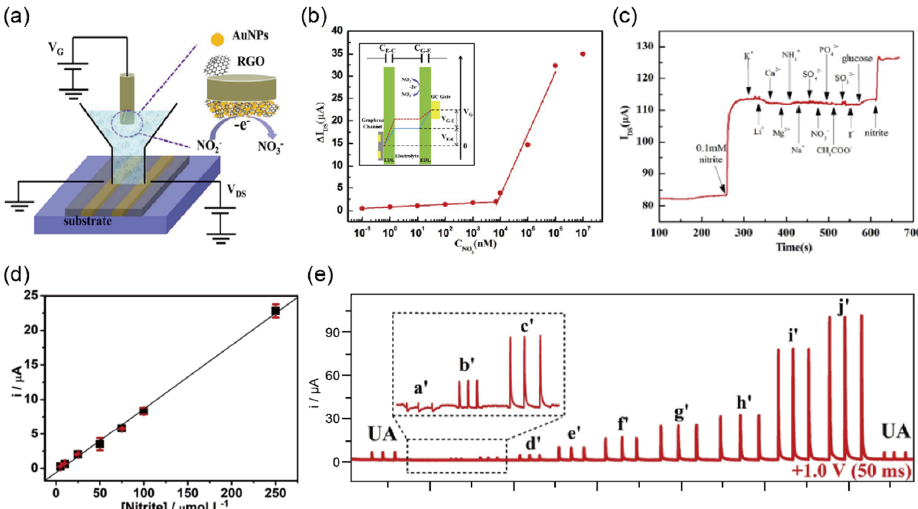
Figure 7. Selective detection of nitrite in biological samples ( a ) Illustration representing the structure and electrical connections of the graphene electrochemical transistor (GECT) sensor. ( b ) Calibration curve of changes of channel current ( Δ I DS ) versus concentration of nitrite from 0.1 nM to 7 µM (V D = 0.2 V). Top ‐ left inset shows the sensing principle of GECT toward nitrite. ( c ) Interference test with various ions such as K + , Li + , Ca 2+ , Mg 2+, NH 43+ , Cl − , NO 3 − , SO 42 − , PO 43 − , CH 3 COO − , SO 32 − , I − , and glucose against 0.1 mM nitrite (reprinted with permission from Ref. [41]; copyright 2019, Elsevier). ( d ) Calibration curve of different concentrations of nitrite from 0.5 to 250 µ M. The limit of detection (LOD) is 0.03 µ M with linearity (R 2 ≥ 0.9986). ( e ) Amperometric measurement operated at an applied potential of 1.0 V (50 ms each) with triplicate injections of nitrite in uric acid solution (a (cid:48) –j (cid:48) : 0.5–250 µ M) (reprinted with permission from Ref. [42]; copyright 2020,